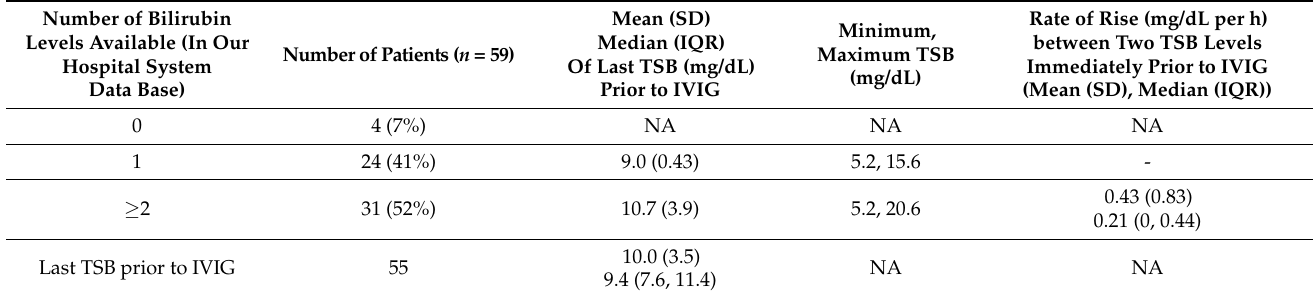
Table 4. Bilirubin levels prior to first IVIG